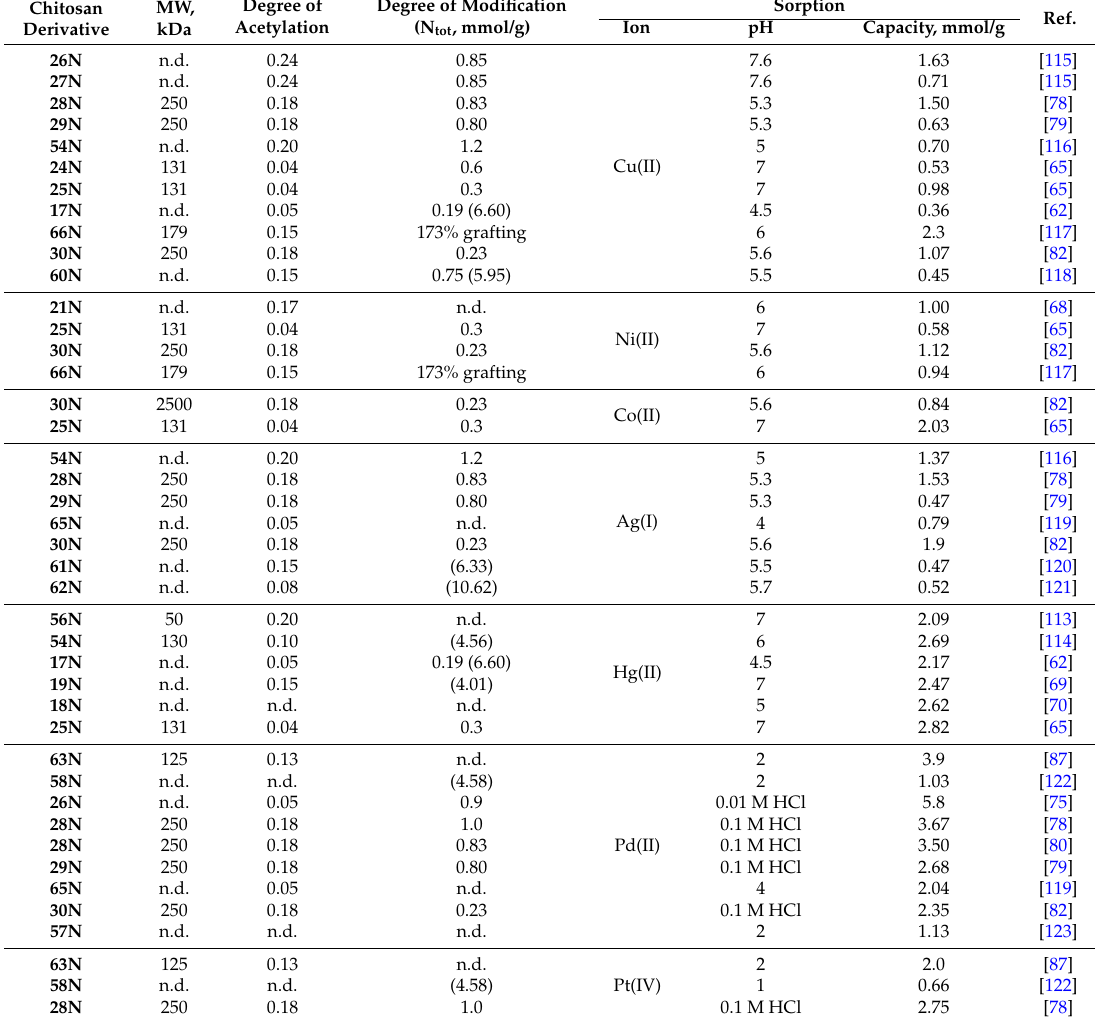
Table 3. Structure and sorption properties of N-containing chitosan